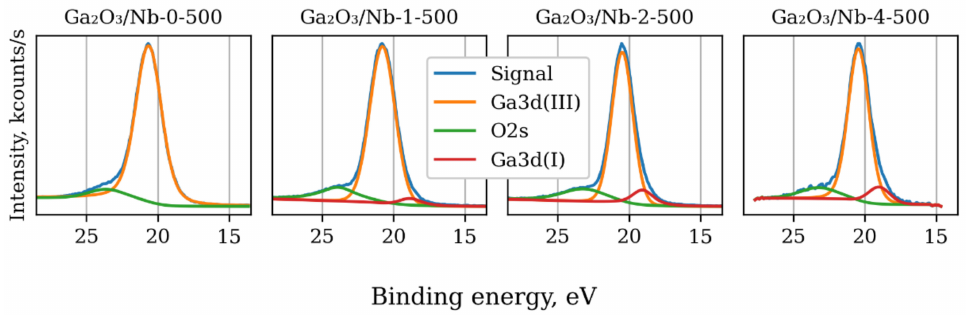
Figure 4. Deconvolution of Ga3d XPS spectra of materials with different Nb content and same annealing temperature.